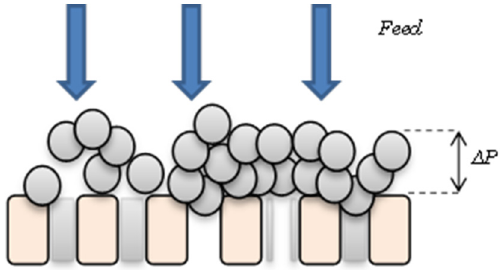
Figure 1. Diagram of the combined fouling mechanisms. Colloids or small particles